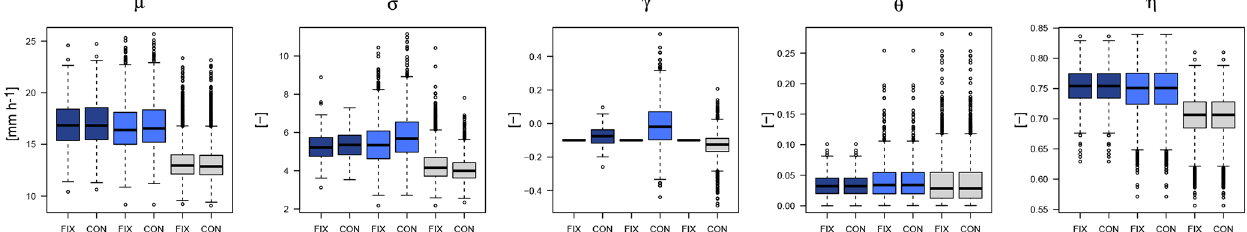
Figure A3. Koutsoyiannis parameters obtained for each dataset (LS in dark blue, SS in light blue and DS in grey) when fixing the shape parameter to 0.1 for all stations (FIX) or constant over all durations per station